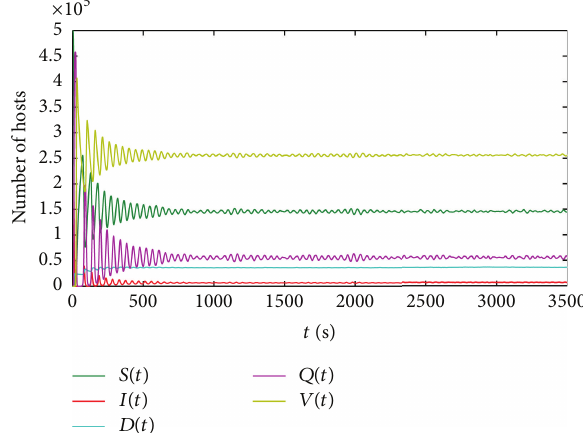
Figure 9: Simulation result of the five kinds of hosts when 𝜏 < 𝜏 0 .